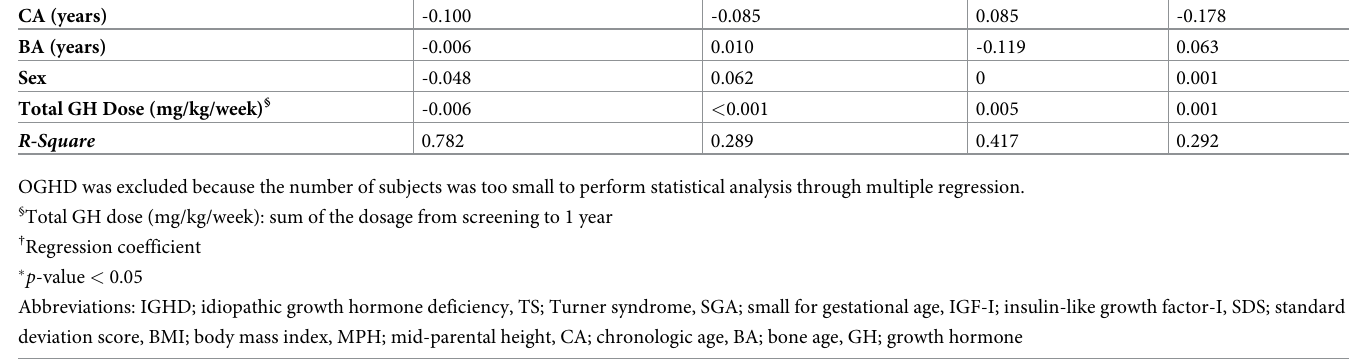
OGHD was excluded because the number of subjects was too small to perform statistical analysis through multiple regression. § Regression coefficient � p -value <